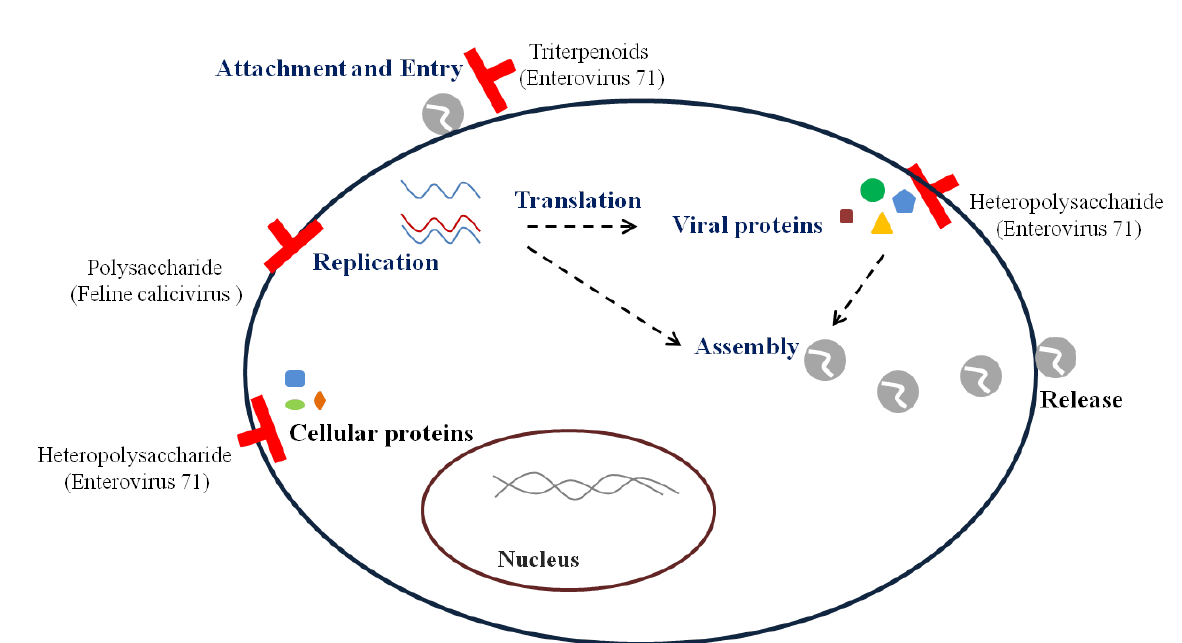
Figure 2. Inhibitory mechanisms of antiviral bioactive compounds against non-enveloped viruses.